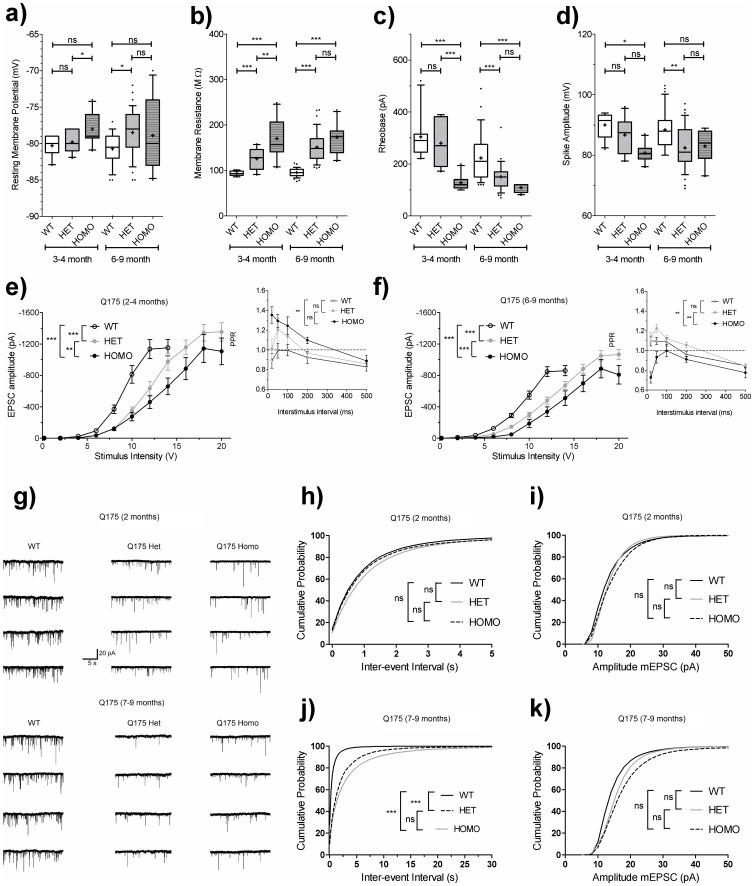
Electrophysiological deficits in zQ175 mice.Box and whisker plots of (A) resting membrane potential (B) membrane resistance (C) rheobase current and (D) action potential amplitude from MSNs in zQ175 wild-type, heterozygous and homozygous mice at 3–4 and 6–9 months of age. Box and whisker plots: + = mean, box = interquartile range, whiskers = 10–90 percentile, outliers = closed circles. (E–F) Measurement of evoked EPSCs in MSNs following cortical stimulation in zQ175 wild-type, heterozygous and homozygous mice at (E) 3–4 and (F) 6–9 months of age. (E–F inset) Paired-pulse ratio (inter-stimulus interval = 20–500 ms) at (E, inset) 3–4 months and (F, inset) 6–9 months for all genotypes. (G) Representative traces of mEPSCs from zQ175 wild-type, heterozygous and homozygous mice at 2 and 7–9 months of age. (H–K) Average cumulative plots of mEPSC inter-event interval (0.25 s bins; H, J) or amplitude (2 pA bins; i, k) in all 3 genotypes at (H–I) 2 months and (J–K) 7–9 months of age. zQ175 mice show a minor reduced frequency at 2 months of age, and a strongly depressed mEPSC frequency at 7–9 months of age (note difference in y axis in J compared to K). Mean mEPSC amplitude showed a slight increase in the frequency distribution towards higher amplitude events in the zQ175 mice, which appeared more pronounced in the 7–9 month age group (see also Table 1). Statistical analysis was performed as described in methods (one-way ANOVA values shown in H–K). ns = not significant, *p<0.05, **p<0.01, ***p<0.001.